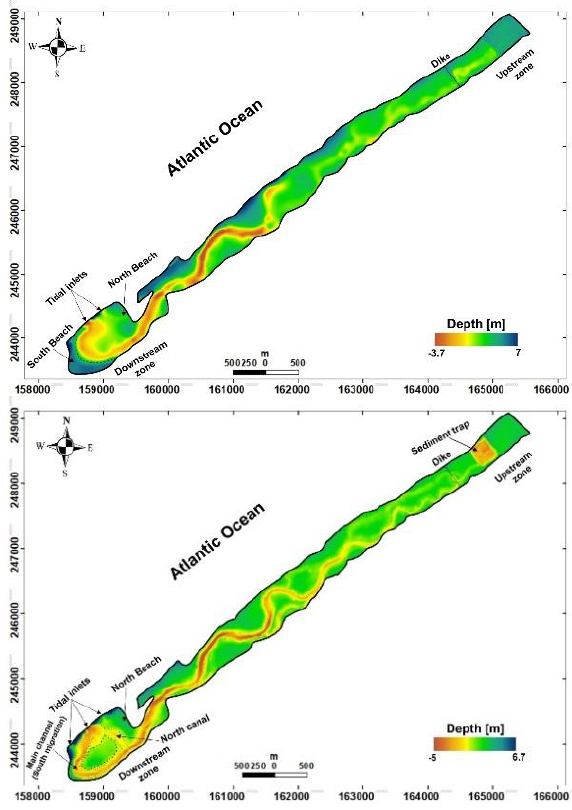
Figure 7. Bathymetric state of the Oualidia lagoon in 2006 (top) and 2012